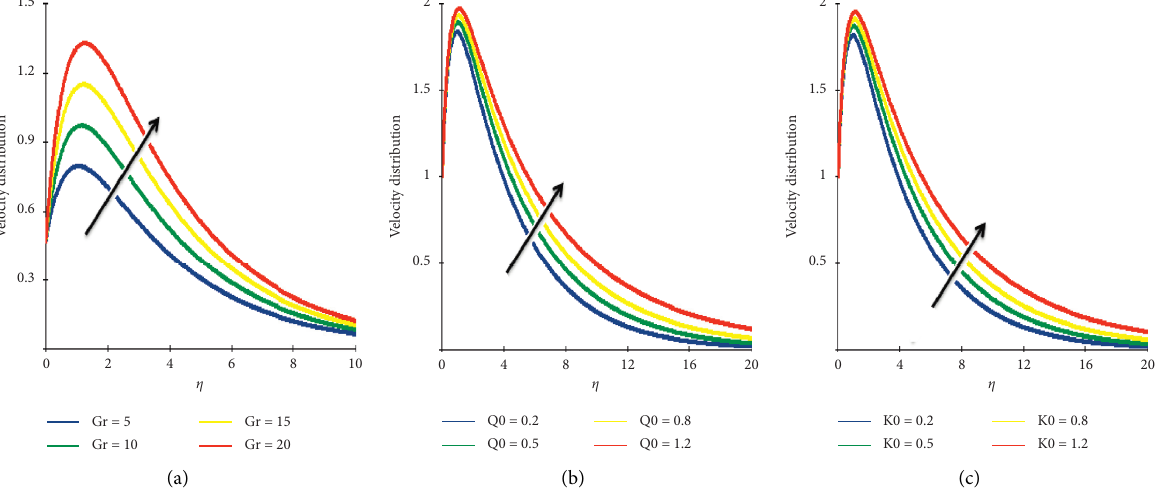
Figure 7: Sketch velocity profile for changing Gr, Q